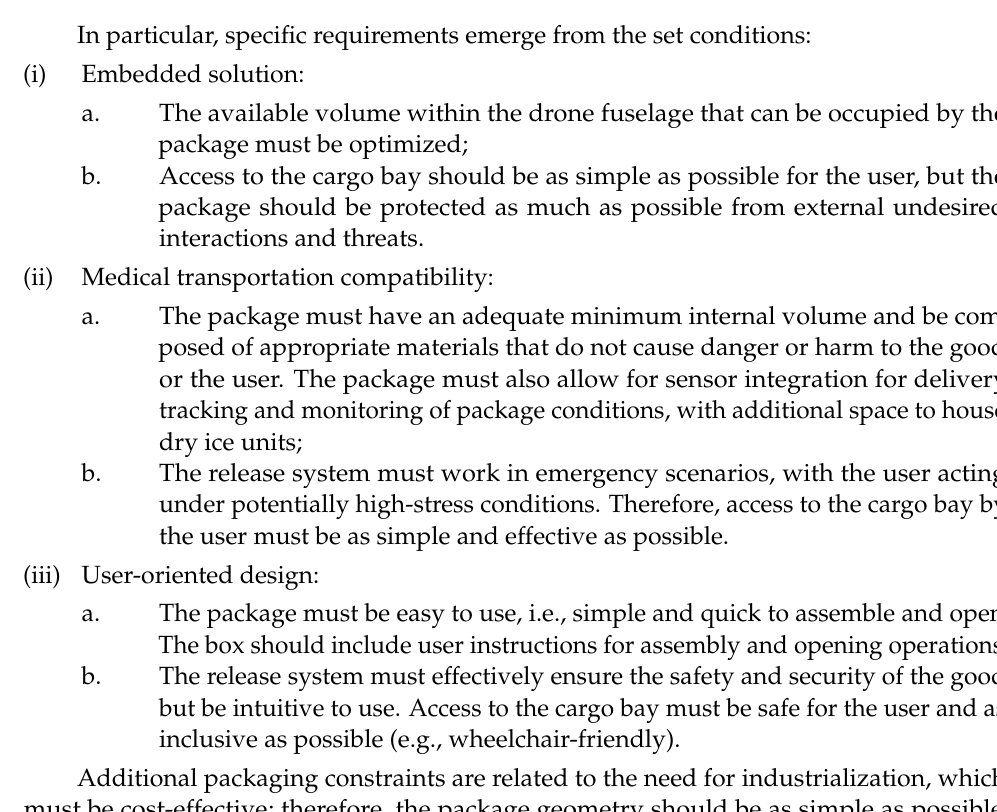
Figure 1. Qualitative schematic of the proposed cargo bay (dimensions in mm): ( a ) top view and ( b ) three-dimensional view.